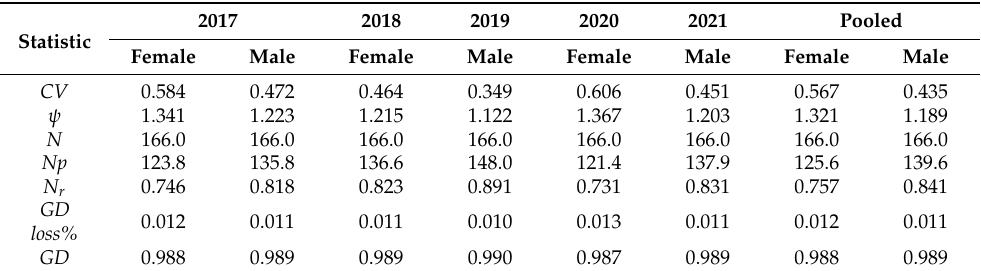
Table 7. Coefficient of variation ( CV ), sibling coefficient ( ψ ), effective number of parents ( N p ), relative effective number of parents ( N r ), and genetic diversity ( GD ) for P. orientalis female and male strobili production ( N = 166 clones).